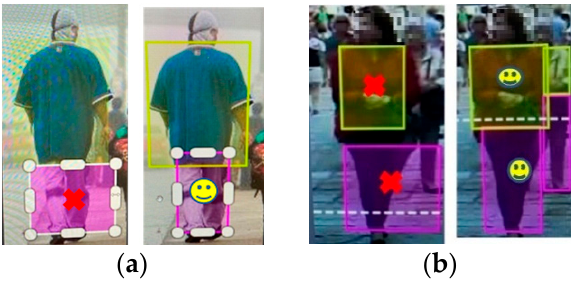
Figure A1. ( a ) how to annotate a trouser without including part of the background, ( b ) the all shirt should be included inside the Bbox.